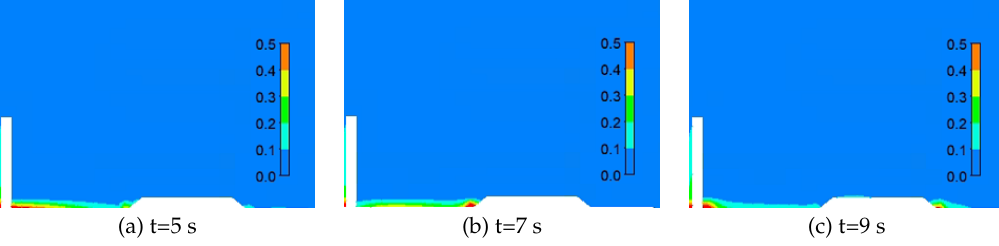
Fig. 19. Contour of sand volume fraction around the embankment at different times under single wind-break wall